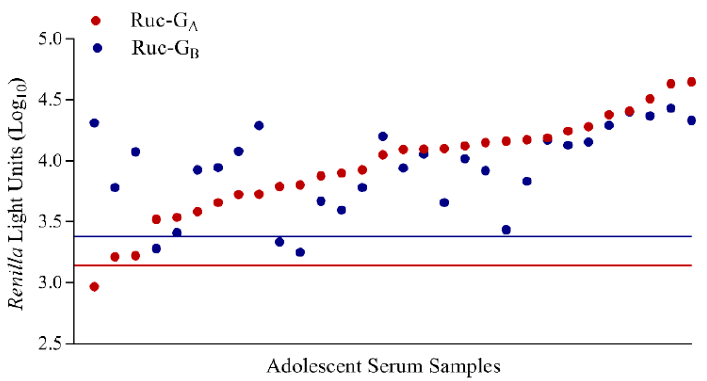
Figure 6. Detection of subtype-specific, anti-RSV-G IgG antibody responses. Murine immune responses were evaluated following primary and secondary intranasal infection with RSV-A2 or -B1. The mean reactivities against Ruc-G A and Ruc-G B antigens are shown in red and blue bars, respectively, and error bars represent standard deviations. Data were normalized against murine anti-FLAG antibody. Cutoff values for a positive signal were five standard deviations above the mean value of the negative control and are shown as horizontal red (Ruc-G A ) and blue lines (Ruc-G B ). * Represents a negative result.